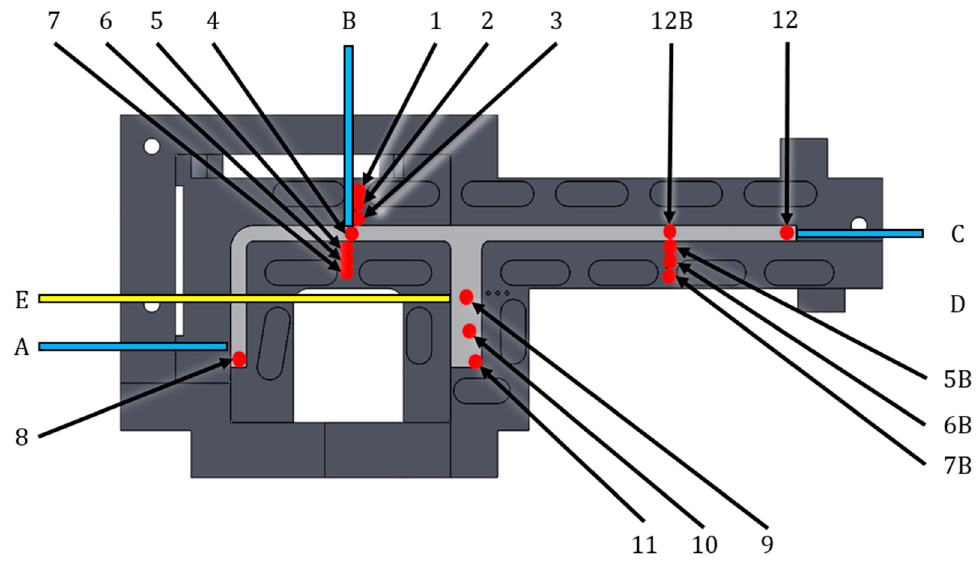
Figure 5. Temperature measuring points (red) and the measuring points of the displacement transducer pairs (blue lines), as well as the point of application for the measurement of the shrinking force (yellow).